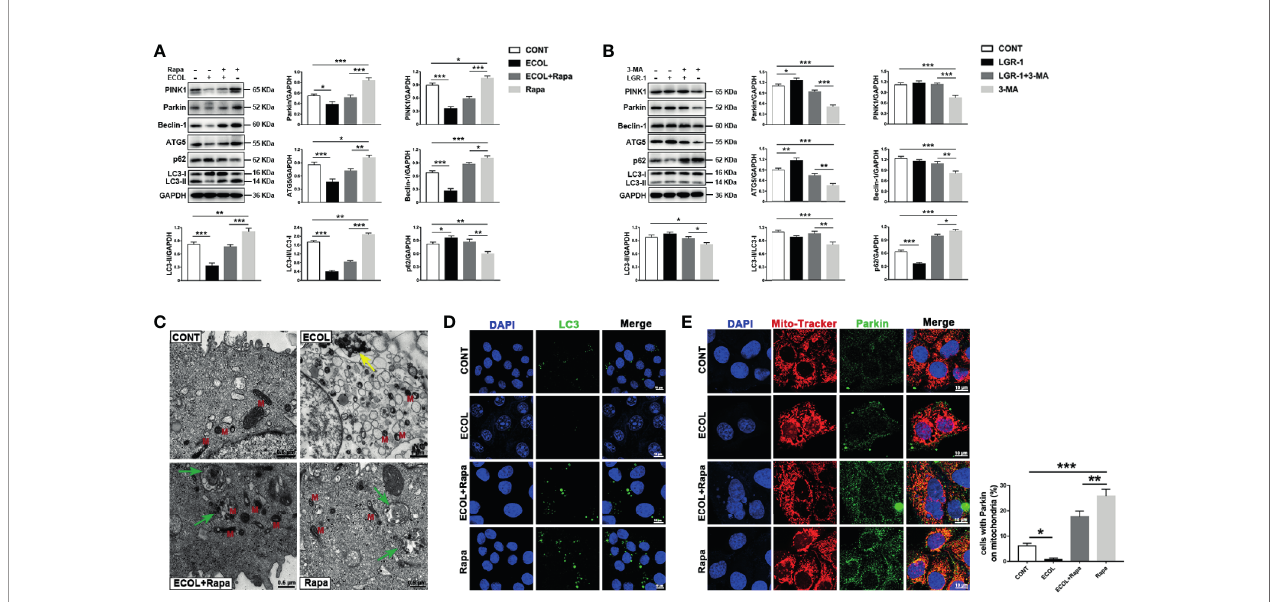
FIGURE 2 | LGR-1 reduces the inhibitory effect of Escherichia coli on mitophagy in MAC-T cells. (A, B) Western blot analysis of PINK1, Parkin, Beclin-1, ATG5, p62, and LC3. The lower right panel shows the protein quanti fi cation using ImageJ software (version 1.50). (C) Representative TEM images of mitochondria and autophagosomes. Red M, mitochondrial; Green arrows, autophagosome; Yellow arrows, E coli . Scale bar, 0.5 µm and 1 µm. (D) Representative immuno fl uorescence images of LC3 (Green). DAPI (Blue) stains the nucleus. Scale bar, 10 µm. (E) Representative images and quanti fi cation of immuno fl uorescence double-labelling Parkin (green) and mitochondrial marker (MitoTracker, Red). DAPI (Blue, nucleus). Scale bar, 10 µm. MAC-T cells were pretreated with 3-methyladenine (3-MA, 5 mM) for 12 h and then treated with LGR-1 (MOI = 1) for 3 h or pretreated with rapamycin (Rapa, 2 m M) for 12 h and then treated with E coli (MOI = 66) for 8 (h) Data presented are mean ± SEM; n = 3. * p < 0.05, ** p < 0.01, *** p < 0.001.